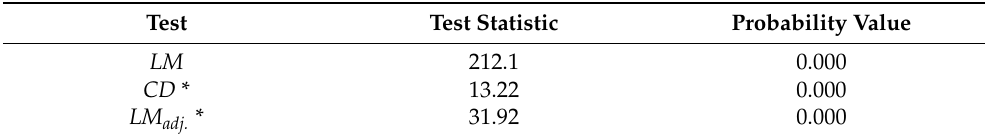
Table 4. Cross-sectional dependence tests’ results.